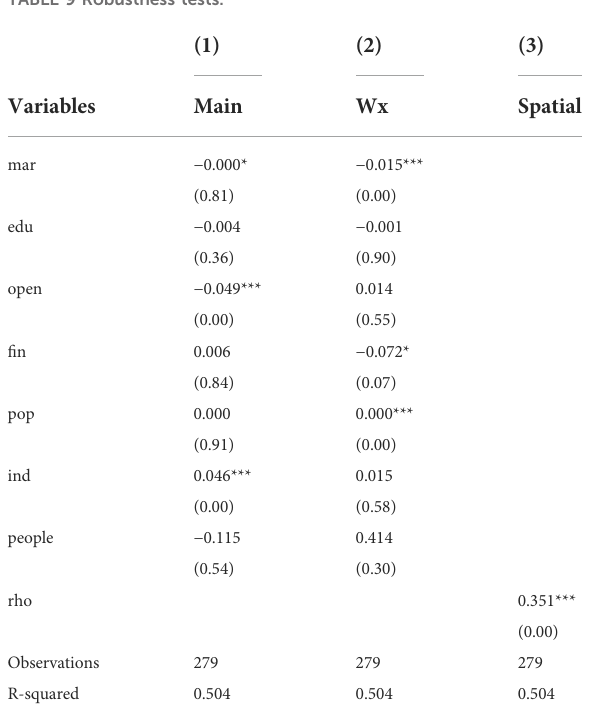
TABLE 9 Robustness tests.